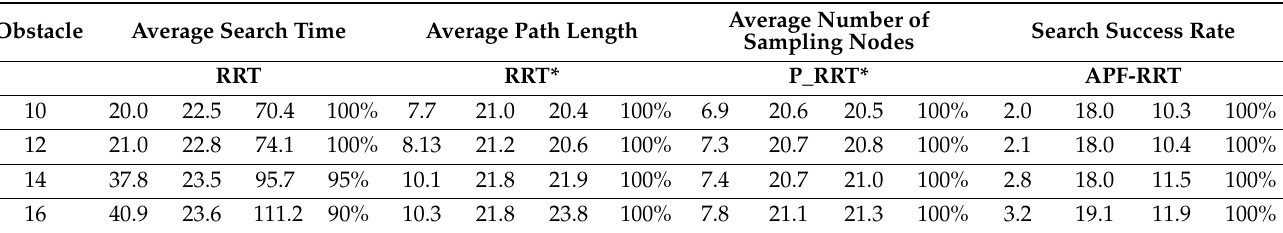
Table 2. Comparison of various algorithms for different obstacle numbers.